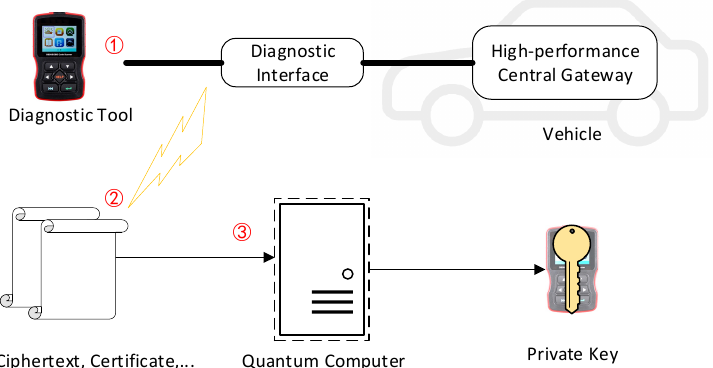
Figure 2. A possible attack trace by using quantum computers in the future.